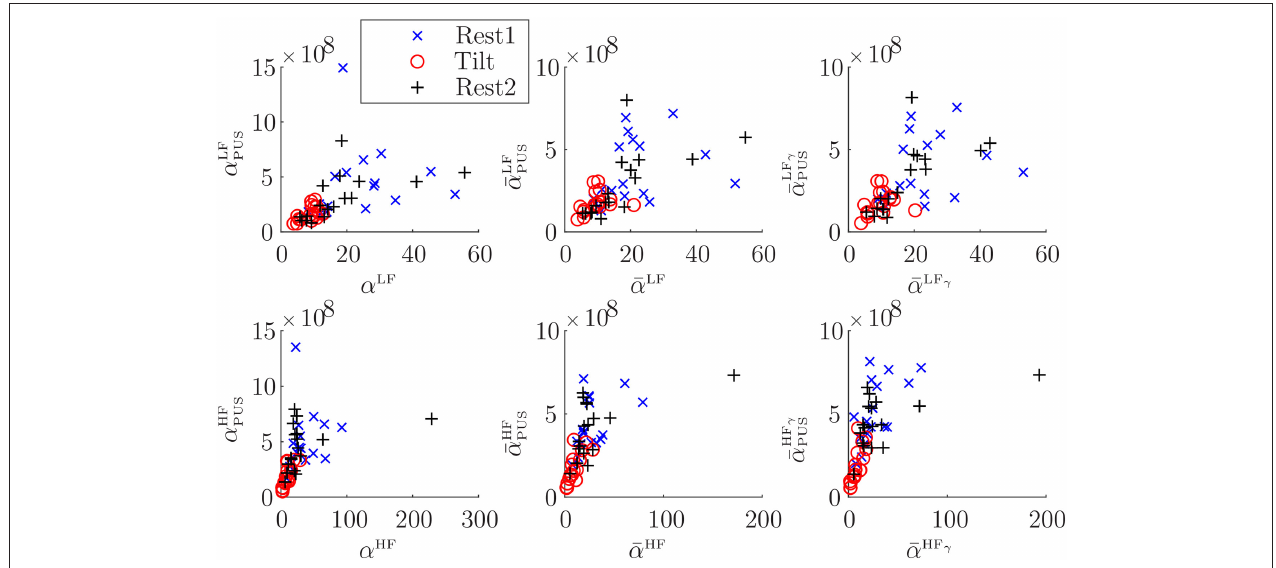
FIGURE 5 | Scatterplots of α vs. α PUS indices (first column), of ¯ α vs. ¯ α PUS indices (second column), and of ¯ α γ vs. ¯ α γ PUS indices (third column).